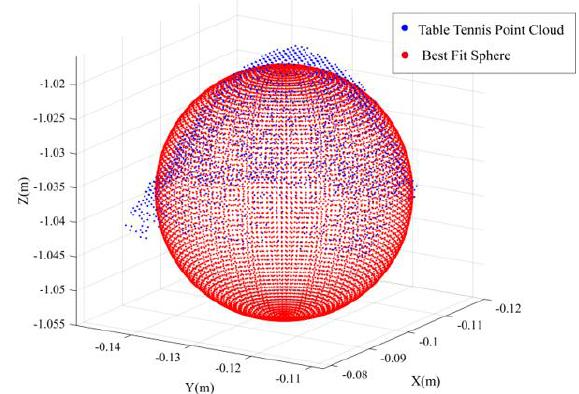
Figure 10. Best fit sphere (Red) to the table tennis ball point cloud